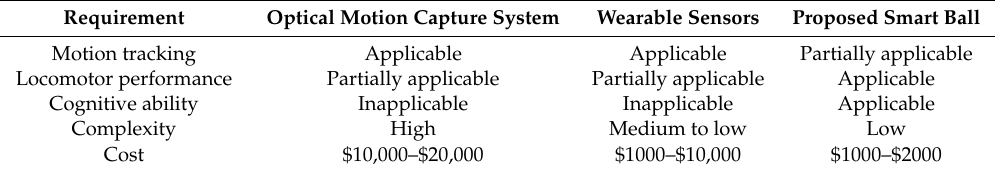
Table 1. Comparison of the proposed smart ball with the optical motion tracking system and the wearable